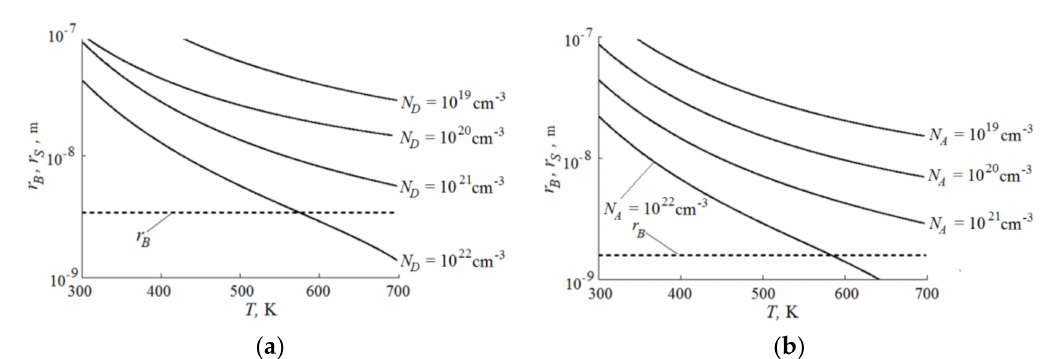
Figure 3. ( a ) Temperature dependence of the Debye shielding radius in the ZnO–Fe system with different iron concentrations; ( b ) temperature dependence of the Debye shielding radius in the ZnO–Cu system with different copper